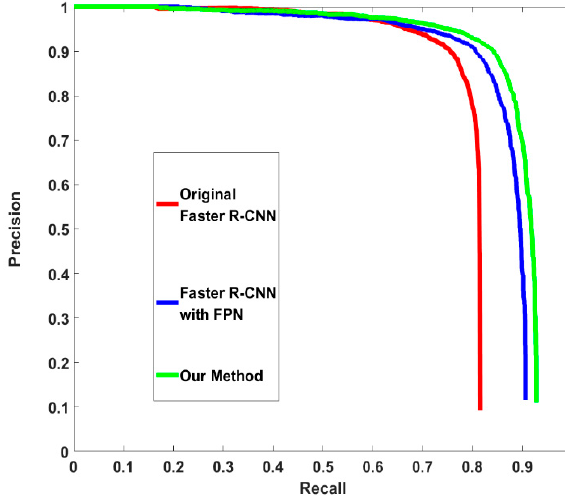
Figure 8. Precision–recall curves of different detectors.